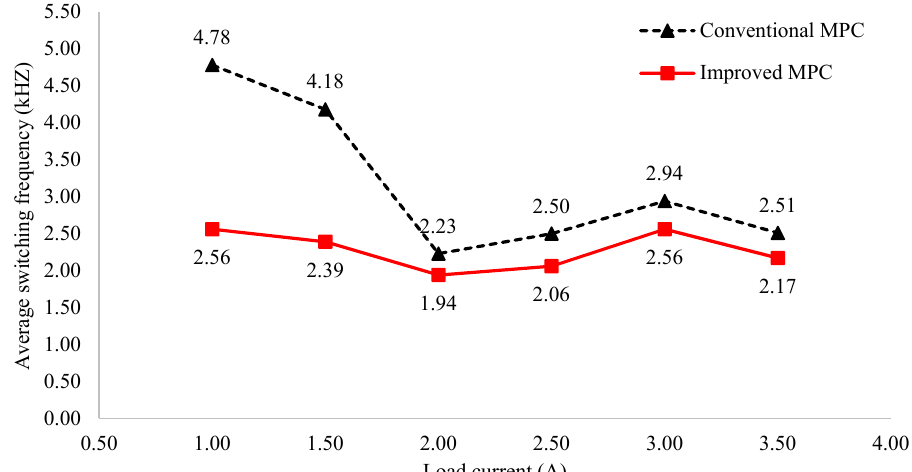
Figure 16. Average switching frequency comparison of normal MPC and improved MPC for asymmetric 3 − level inverter.